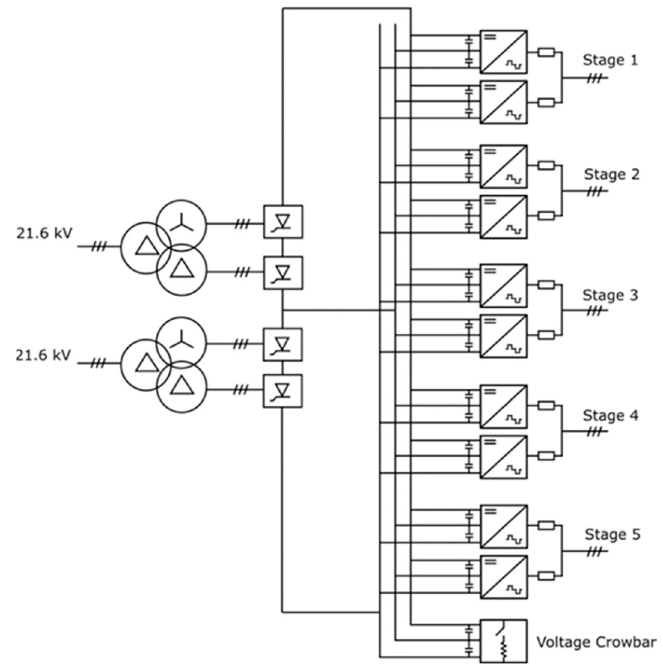
Figure 2. AGPS-CS electrical scheme. Table 1. Main characteristics of step-down transformers and ac/dc converters.